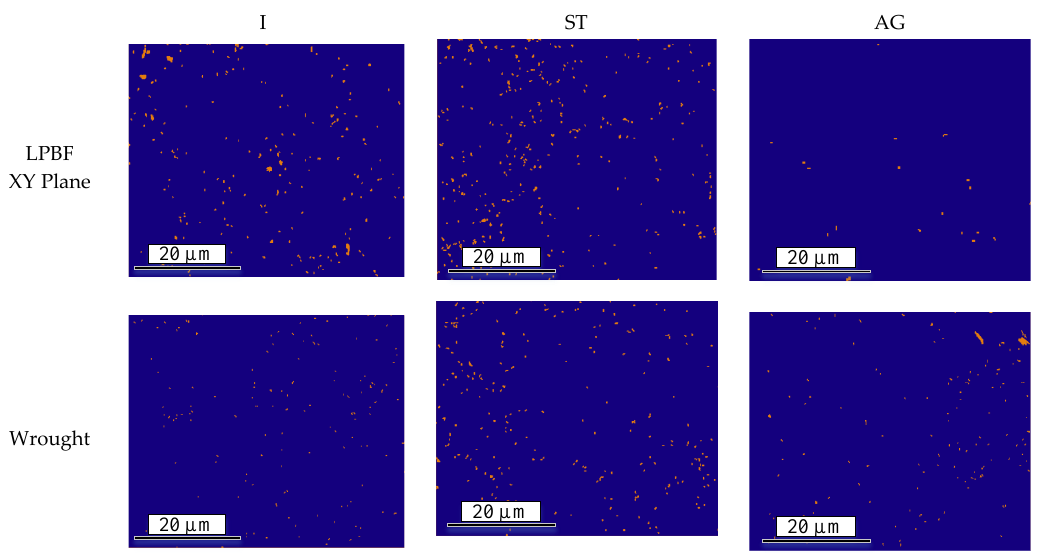
Figure 8. Phase distribution maps of the LPBF and wrought alloys: martensite is presented in blue and RA is presented in orange. Table 6. Table of the measured percentage of RA from the phase distribution maps. RA (wt.%)